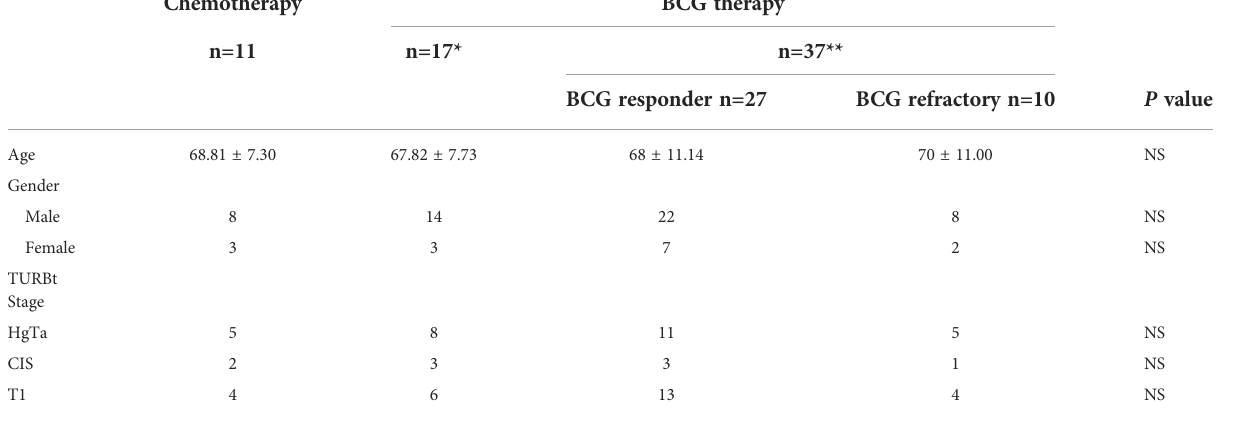
TABLE 1 Characteristics of bladder cancer